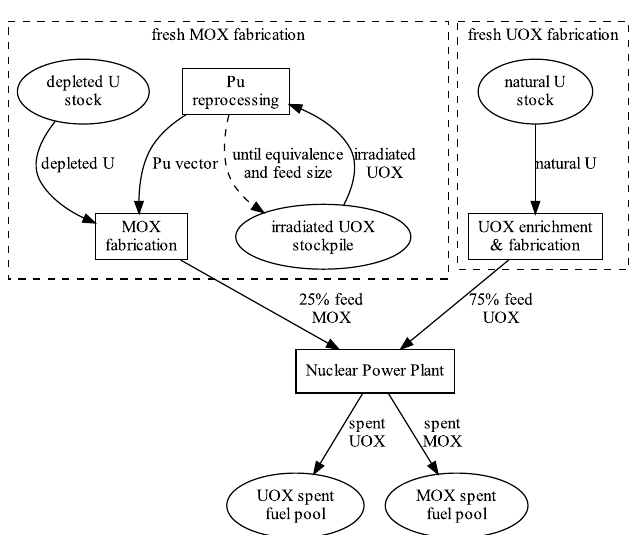
Fig. 7. Spent UOX reprocessing scenario for